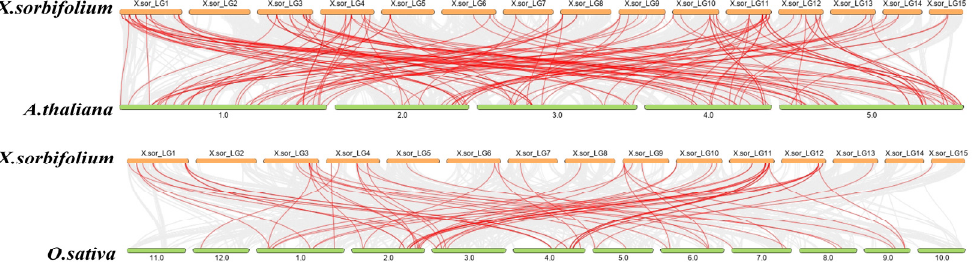
Figure 5. Homolinear AP2/ERF gene analysis between X. sorbifolium , rice, and A. thaliana . The gray lines in the background indicate colinear blocks within the genomes of X. sorbifolium and other plants, while the red line denotes the colinear AP2/ERF gene pairs.